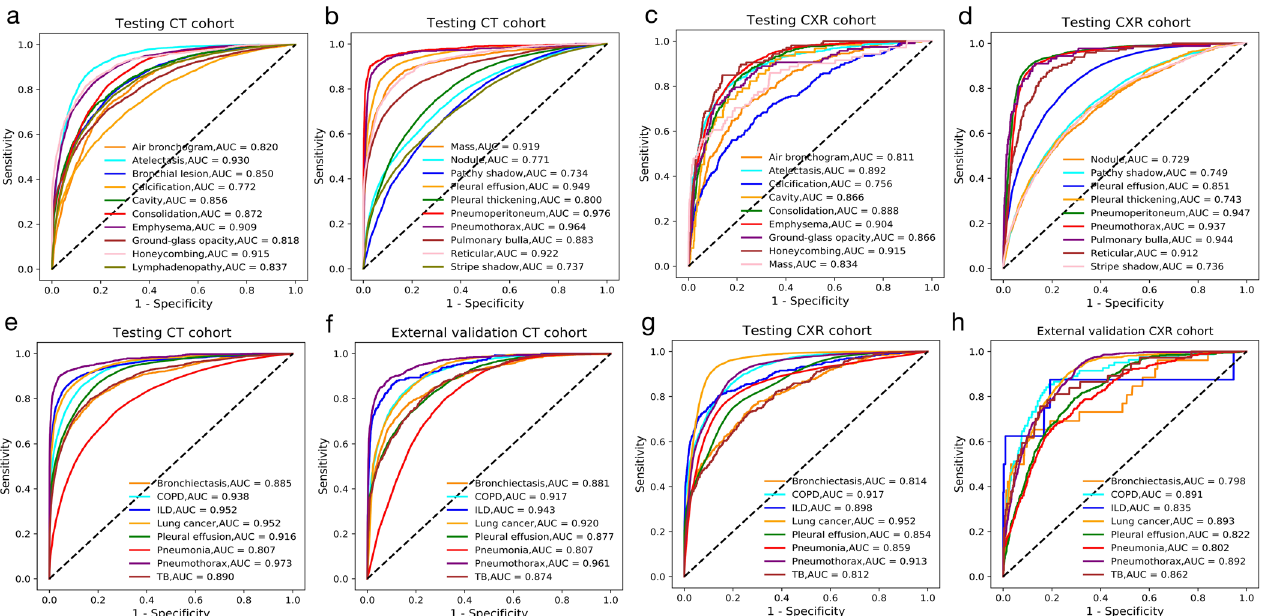
Fig. 2 Model performance of the AI system. a – d ROC curves of AI system in identifying abnormalities based on internal testing CT and CXR cohort. e , f ROC curves of AI system in making 8-disease diagnoses based on the internal testing and external validation CT cohort. g , h ROC curves of AI system in making 8 diseases diagnoses based on the internal and external validation CXR cohort. COPD chronic obstructive pulmonary disease, ILD interstitial lung disease, TB